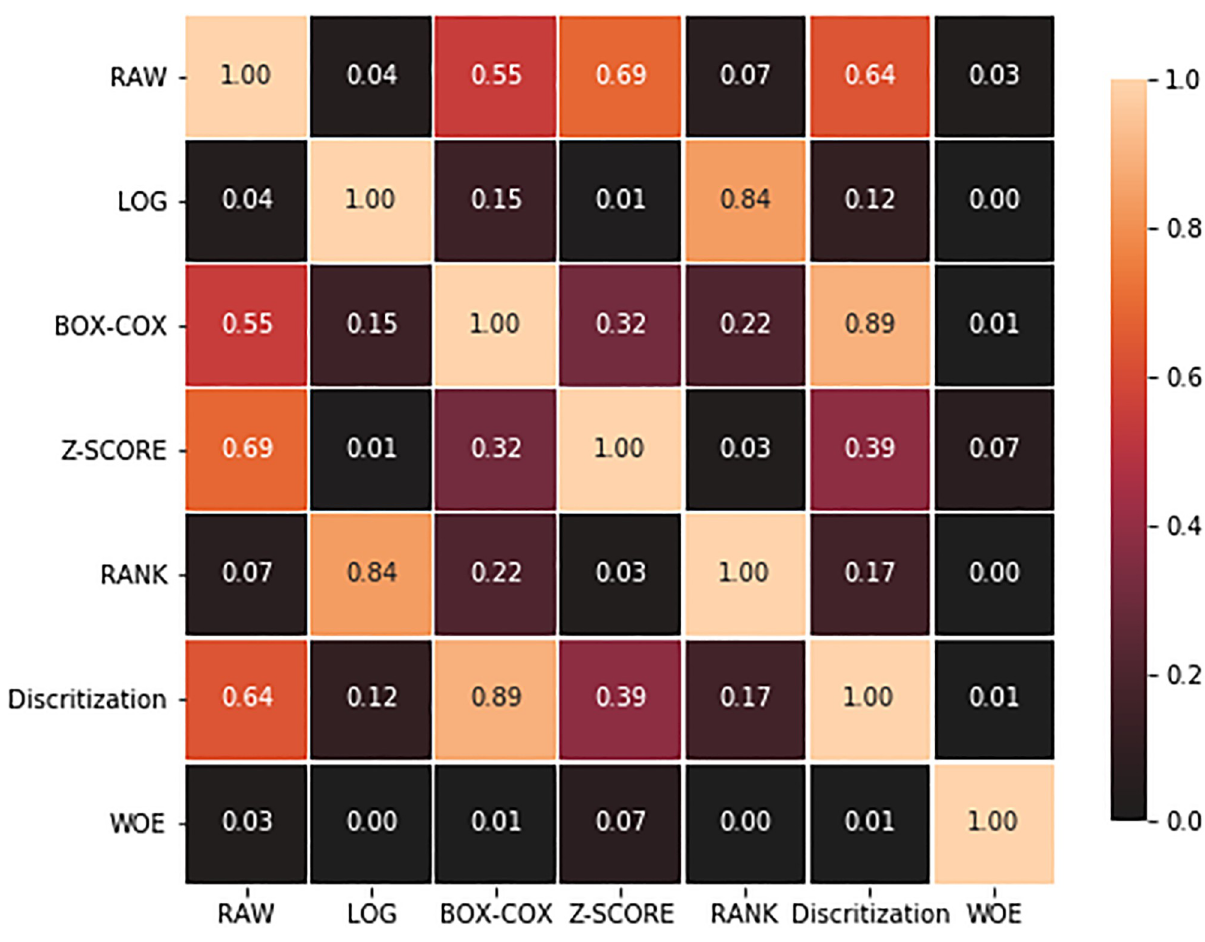
Fig 4. Performance difference heatmap among DT based CCP models in terms of p-value.